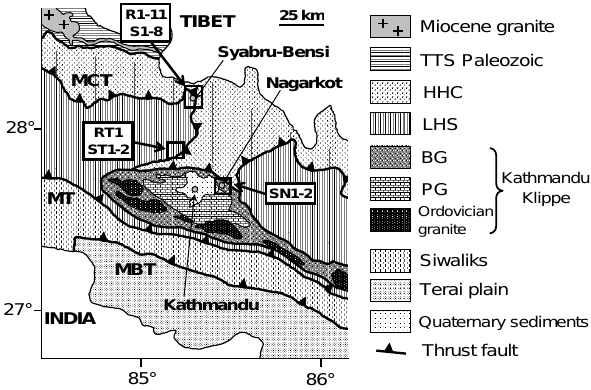
Fig. 1. Location of the sampling sites on a simplified geological map of Central Nepal, after Upreti (1999). TTS: Tethys Tibetan Sediments; HHC: High Himalayan Crystalline; LHS: Lesser Himalayan Sequences; BG: Bhimphedi Group; PG: Phulchauki Group; MCT: Main Central Thrust; MT: Mahabharat Thrust; MBT: Main Boundary